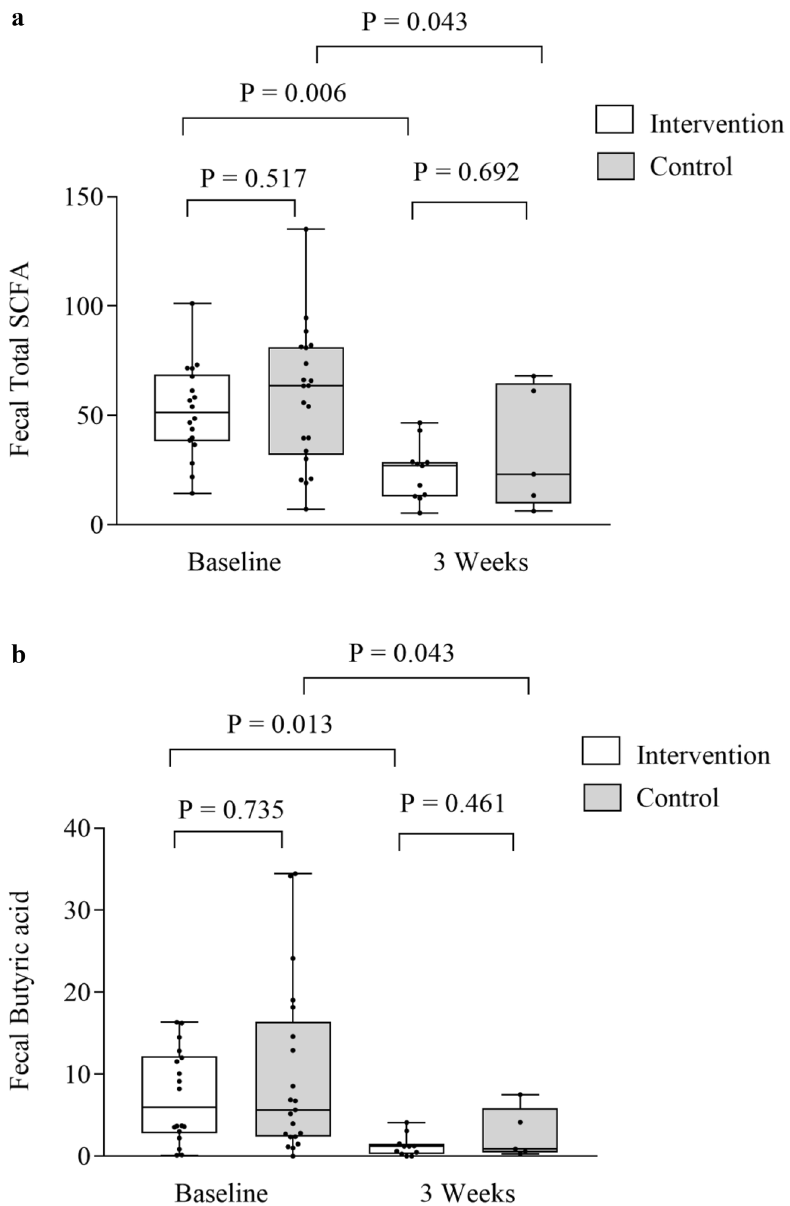
Figure 2. Fecal total SCFAs and the intervention and control group at baseline and 3 weeks. Data are total SCFAs given as individual values (dots) and box plots (median and interquartile range) with minimum and maximum